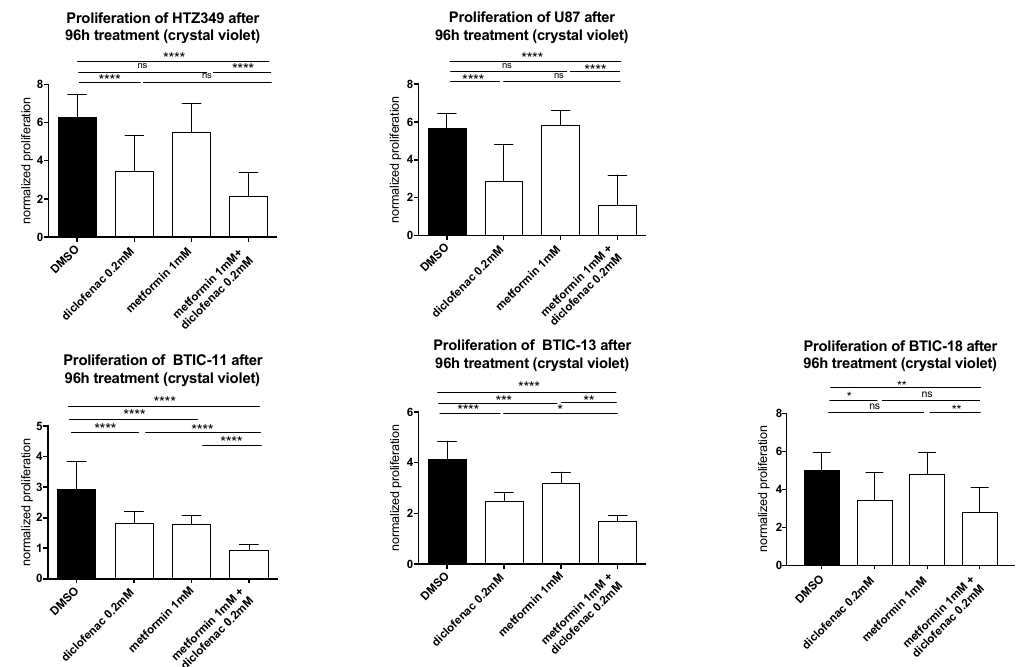
Figure 1. The effects of metformin, diclofenac, and both agents on proliferation were investigated using crystal violet staining at a 96-h time point. Results are expressed as mean ± SD, and were analyzed by two-way ANOVA, p = 0.0332 (*), p = 0.0021 (**), p = 0.0002 (***), p ≤ 0.0001 (****) compared pairwise, i.e., the metformin-treated versus metformin and diclofenac conditions.